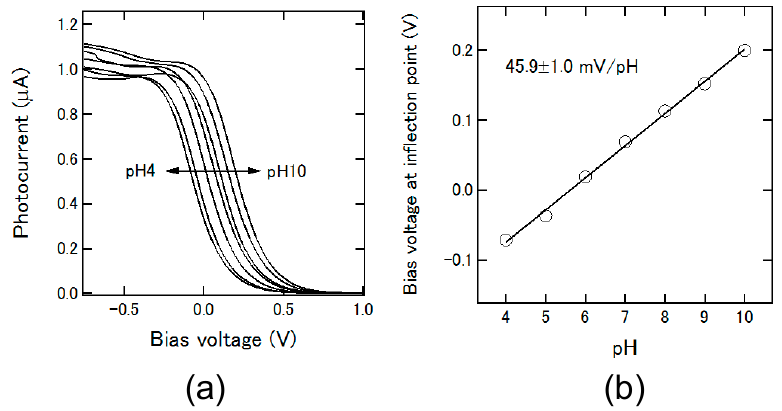
Figure 4. ( a ) I-V curves measured for plugs with different pH values; ( b ) Inflection points of I-V curves plotted as a function of pH.